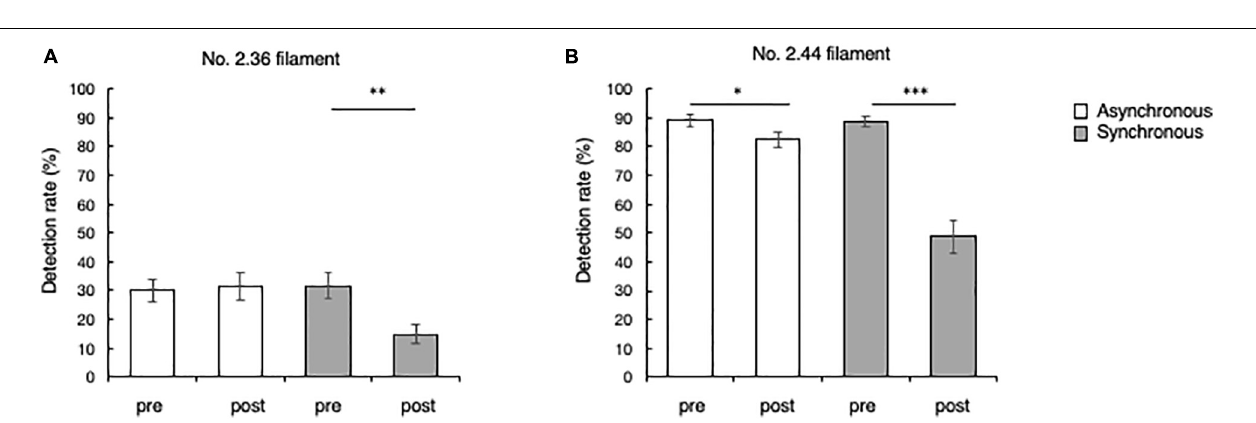
FIGURE 4 | Ownership and disownership scores before and after the RHI. (A) Ownership score (SoO) from Question 1 in synchronous and asynchronous conditions. (B) Disownership scores (DisO) from Question 2 in synchronous and asynchronous conditions. Pre indicates results before the illusion operation, and post indicates results after the illusion operation. In the box-plots, the thick horizontal bars indicate the median, and the cross marks indicate the average values. ∗∗∗ p < 0.0005; error bars ± 1 SD.